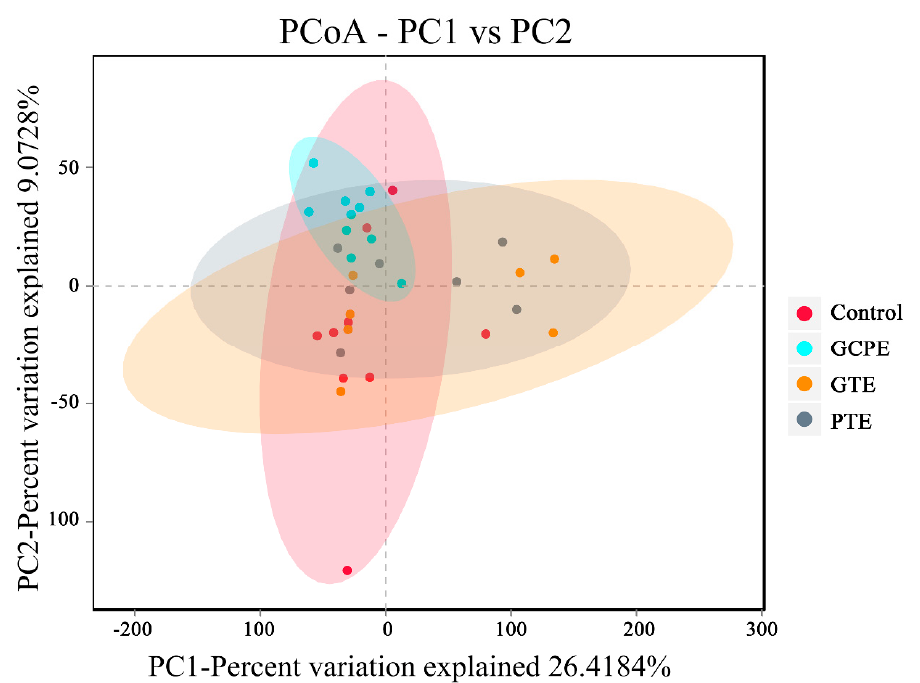
Figure 6. PCoA plots of microbial communities were based on operational taxonomic units (OTUs) composition, each treatment group is represented by a different color ( n = 10).